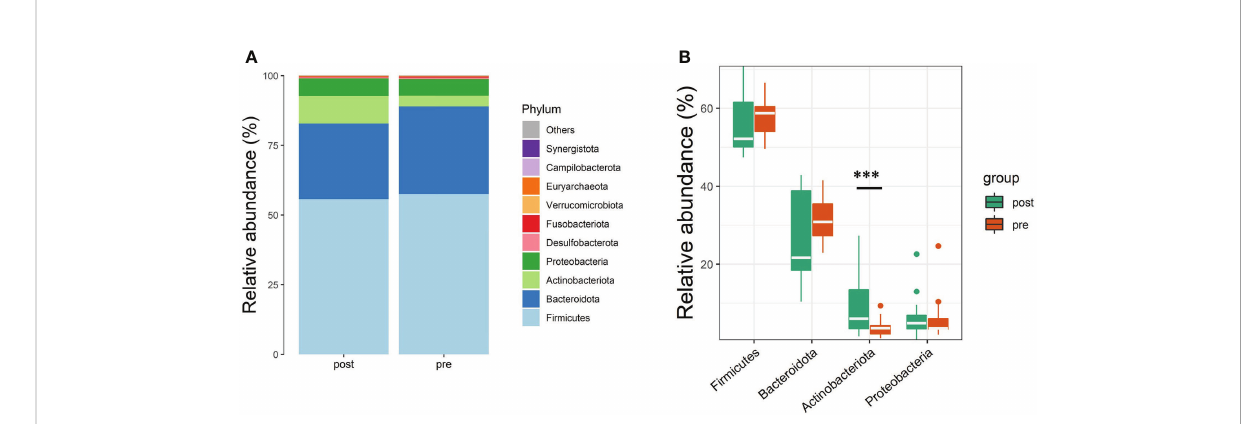
FIGURE 1 Taxonomic pro fi les at the phyla level of pre-antibiotics and post-antibiotics groups. (A) The relative abundances of the top 10 microbial communities identi fi ed at the phyla level between pre-antibiotics and post-antibiotics. (B) The differences in the top 4 phyla (Firmicutes, Bacteriodetes, Proteobacteria, and Actinobacteria) between pre-antibiotics and post-antibiotics. ***, p-value <